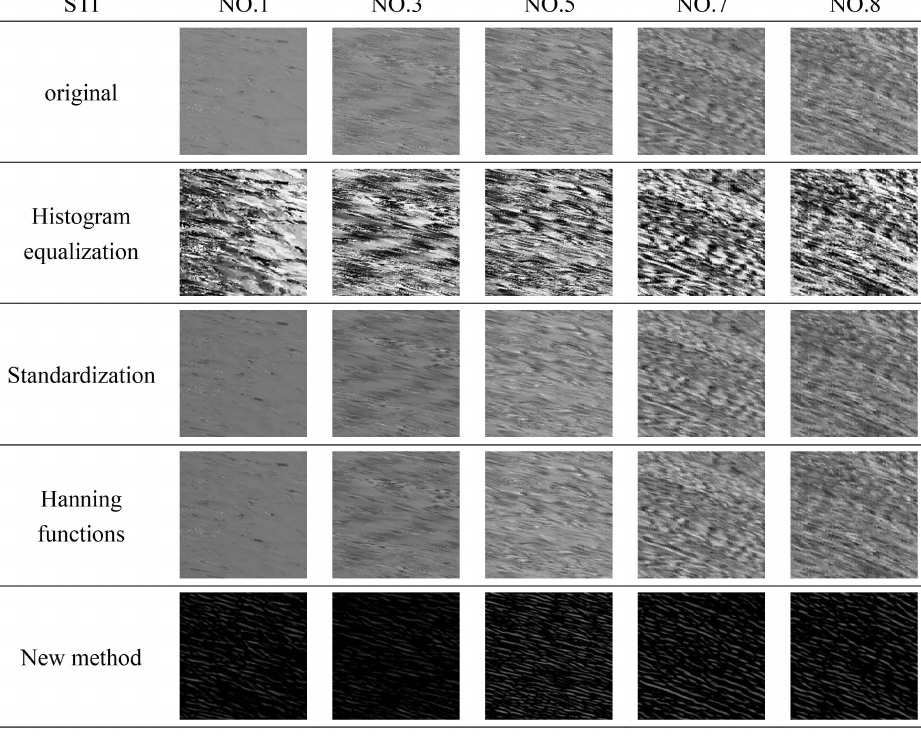
Figure 4. The comparison of preprocessing of space-time